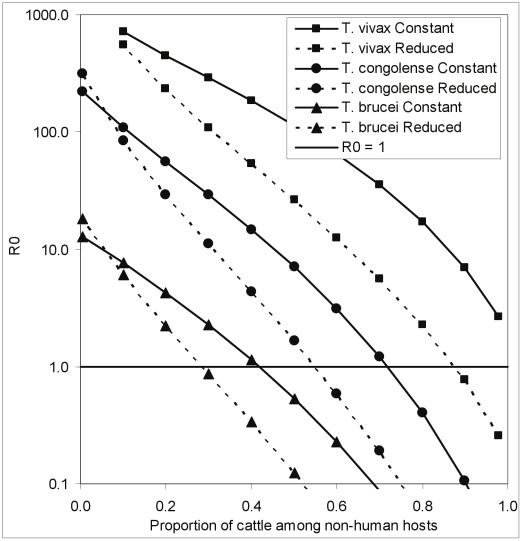
The effect of vector population reduction on the control of T. brucei using insecticide.The relationship between the basic reproductive value, R
0, and the proportion of cattle among all non-human mammalian hosts in the situation where all cattle are treated with an insecticide that kills any fly attempting to feed off that animal. The dotted lines show the further change in R
0 in the circumstance that the imposed mortality results in a decline in the tsetse population.